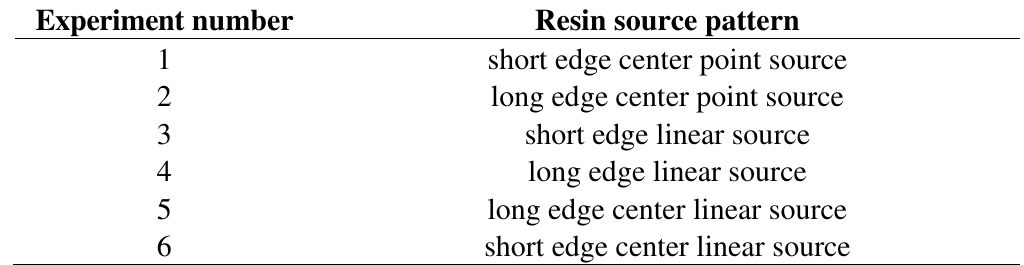
Table 5. Resin Source